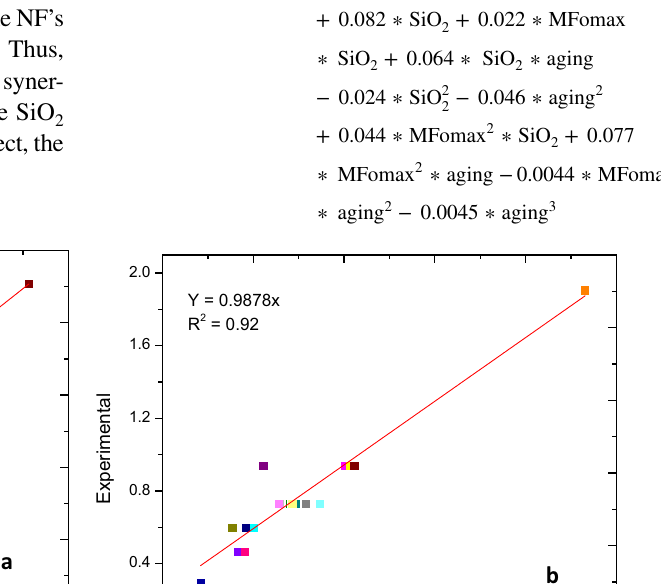
2 NF and b MFomax/SiO 2